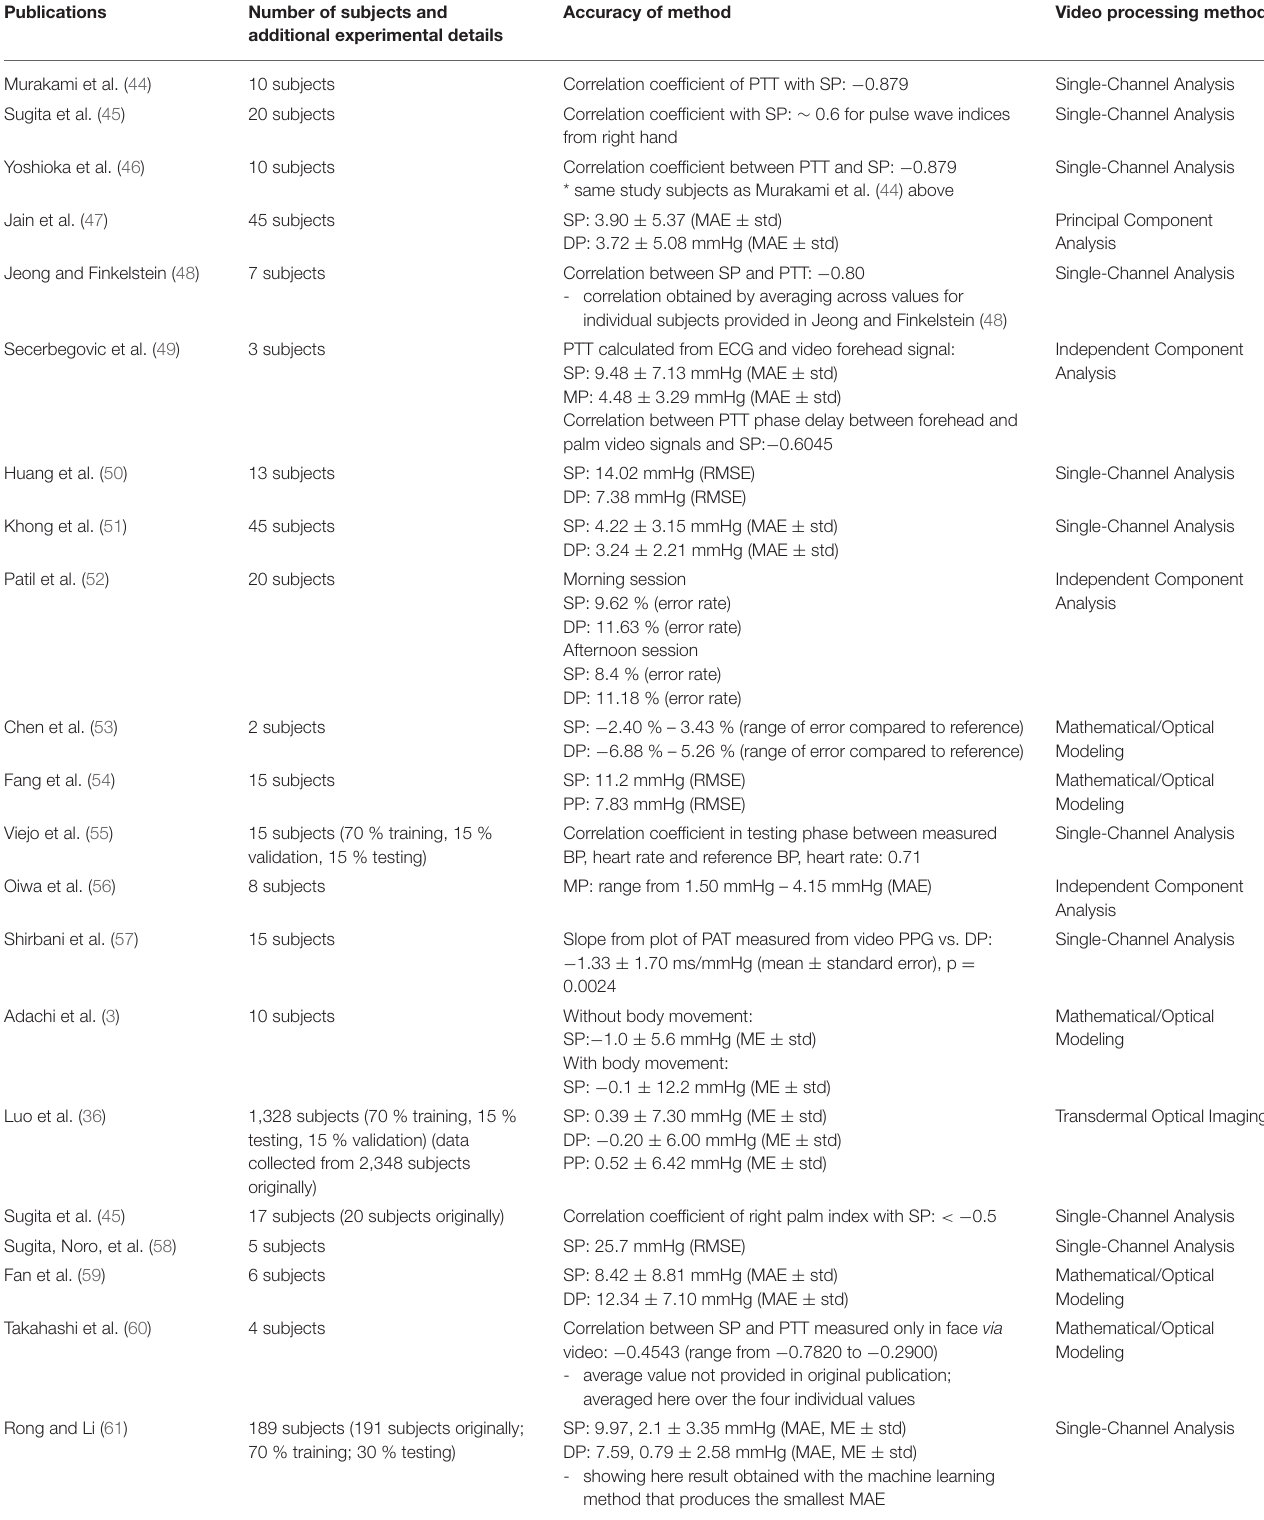
TABLE 2 | Non-contact methods for smartphone/video blood pressure (BP)